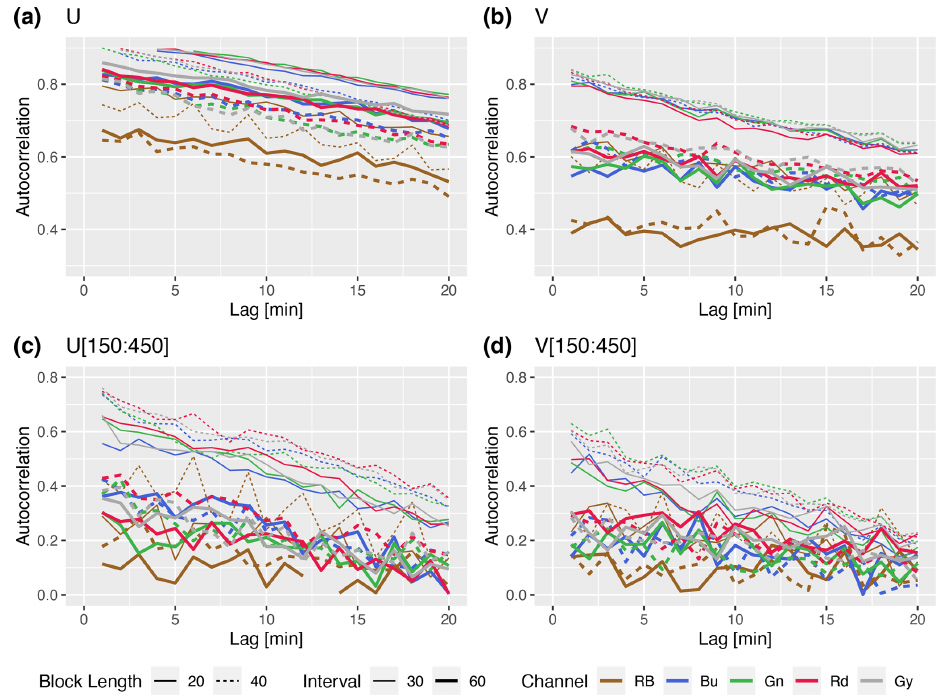
Figure 8. Autocorrelogram for U and V components showing the stability of the motion vectors shown in Figs. 5 and 6. Panels (a) and (b) for all the data, and panels (c) and (d) for the selected period of rapid Cu cloud development between 09:06 to 14:56LT (time steps: 150–